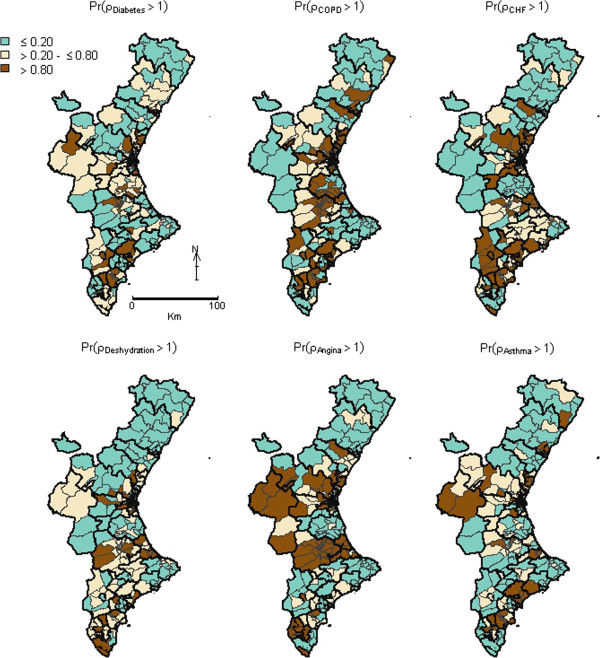
Maps of posterior probabilities that the relative risk for the respective Potentially Preventable Hospitalization was higher than 1. Dark-brown coloured territories are BHZ for which the probability of having a relative risk of PPH admissions higher than 1 for the respective condition is >0.8, and green ones are BHZ for which this relative risk is below <0.2. PPH: Potentially Preventable Hospitalizations; BHZ: Basic Health Zones.